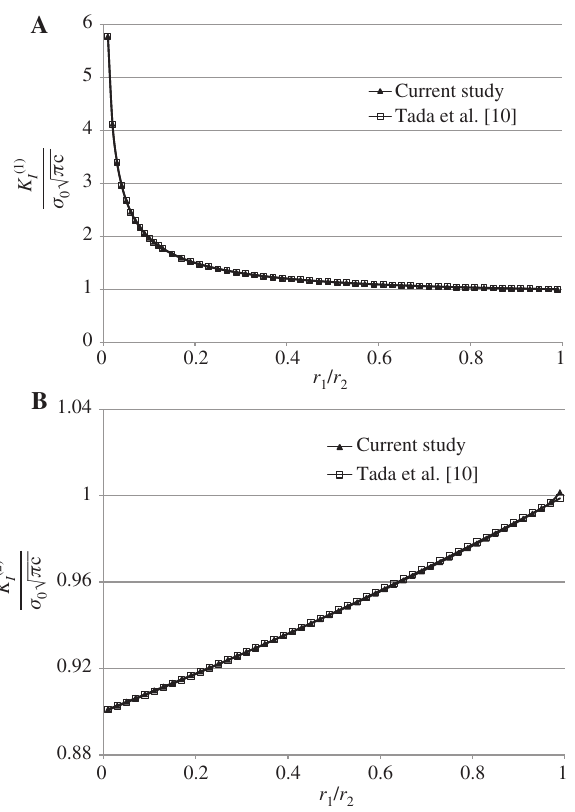
Figure 3: Comparison of the variations of the (A) inner and (B) outer stress intensity factors in terms of r annular crack with those of Tada et al.